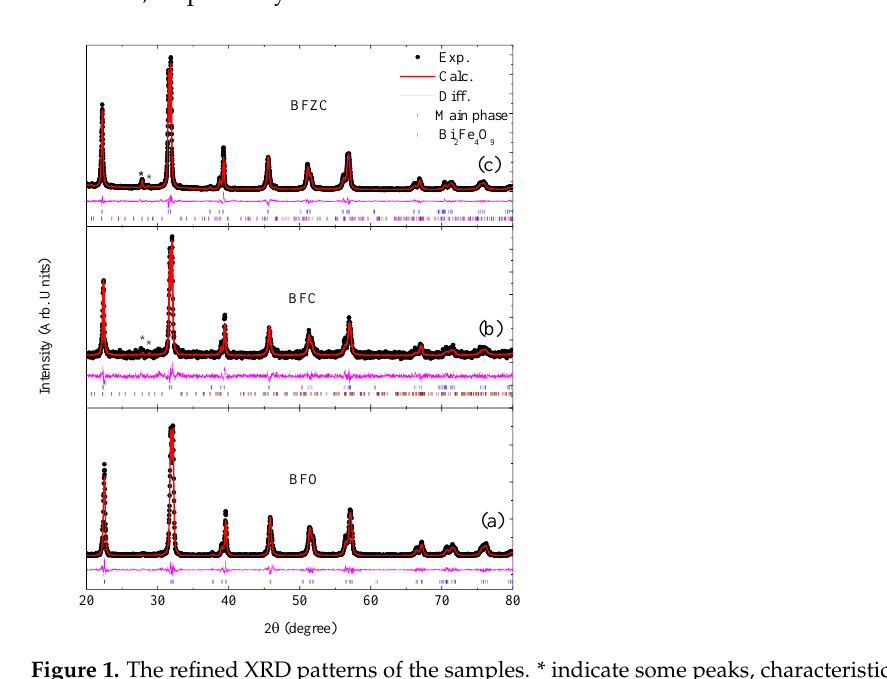
H ( k O e ) Figure 2. The magnetic hysteresis loop of the samples at 300 K. ( a ) BFC, ( b ) BFZC. The magnetic hysteresis loop of BFZC at 10 K is plotted in Figure 3a. The magnetic property of the sample is evidently improved compared with that of BFO. The ferromag- netic characteristics at low temperatures are more obvious than those at room tempera- ture. A well-developed M - H loop together with a small but nonzero remnant magnetiza- tion can be observed at low temperature, as shown in Figure 3b. To understand the origin of the observed ferromagnetism in the BFZC sample at low temperatures, zero field cooled (ZFC) and field cooled (FC) temperature dependent